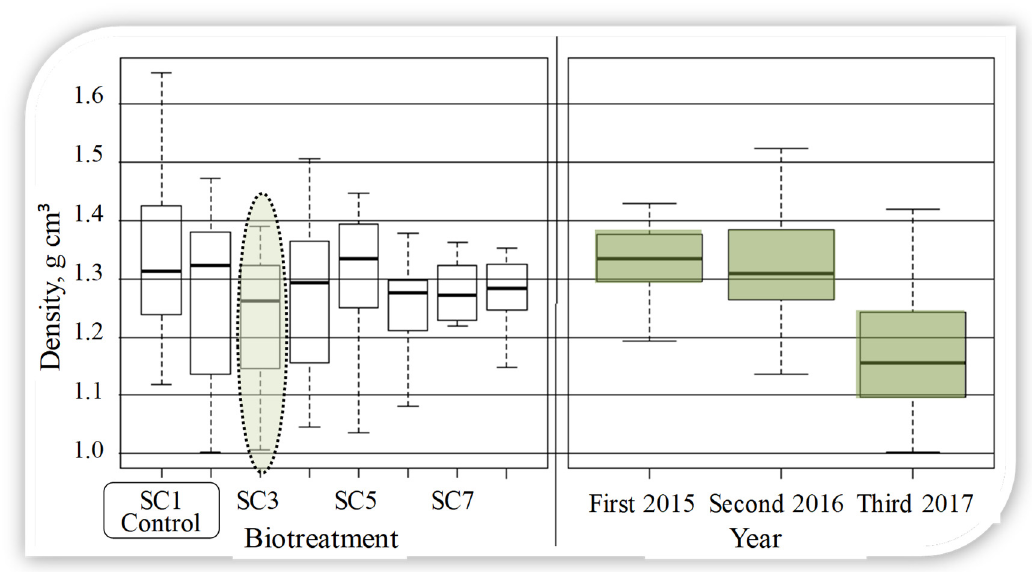
Figure 6. Soil density (g cm − 3 ) dependence on bio-impact(s) time (year) and scenario .